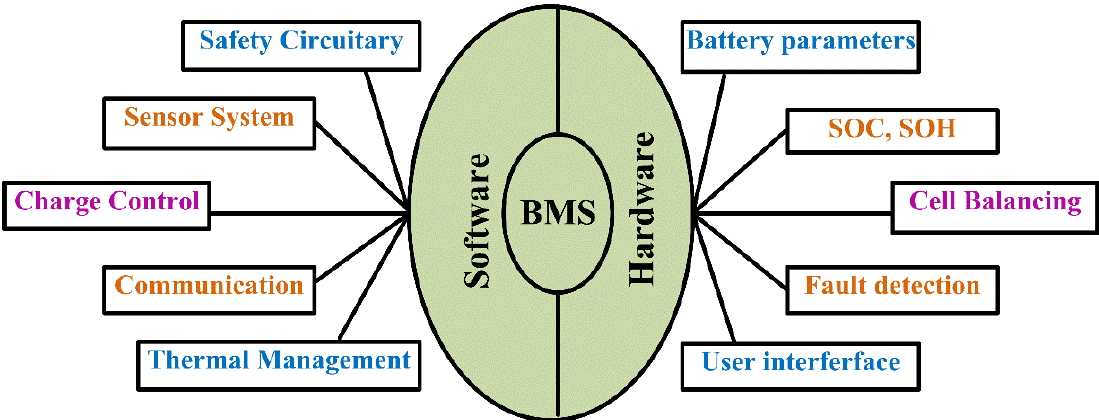
Figure 3. The basic outline of a BMS in an EV.